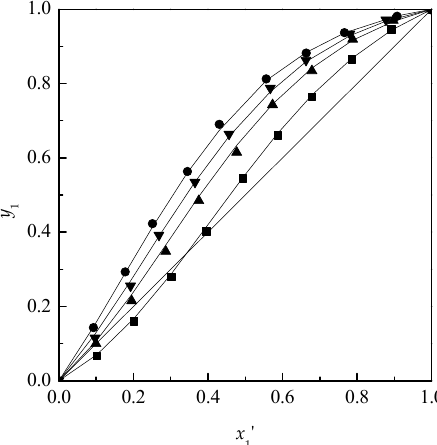
Figure 3. Isobaric VLE diagram for the system of acetone (1) + chloroform (2) + [EMIM][DEP] (3) at 101.3 kPa: ■ , x 3 = 0; ▲ , x 3 = 0.10; ▼ , x 3 = 0.15; ● , x 3 = 0.20; solid line, calculated using NRTL model.